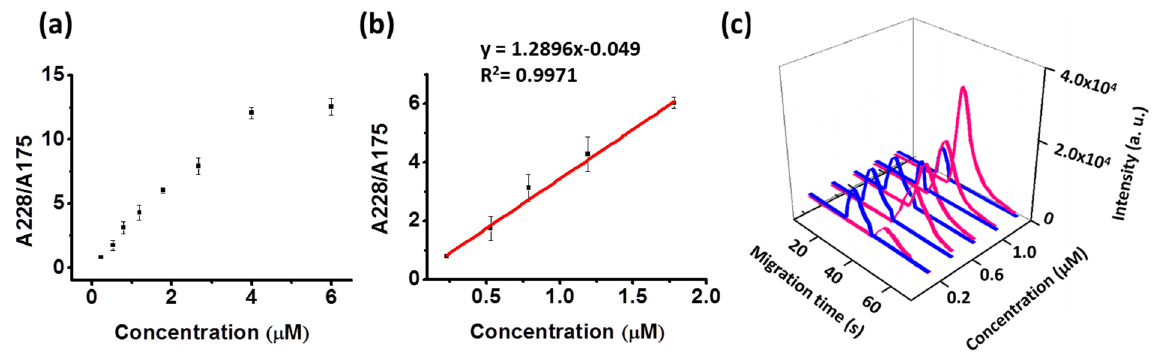
Figure 5. Quantitative analysis. ( a ) Plot obtained by plotting the ratio integrated intensity area of the ion peak from corresponding EICs at m / z 228 (ametryn) to the ion peak at m / z 175 (arginine) versus the concentration of ametryn. The samples contained ametryn with different concentrations (0.2–6 µ M) spiked with arginine (1.5 µ M). Three replicates were conducted for each concentration. The voltage applied on the inlet of the mass spectrometer was − 4.5 kV, while the length of the tapered capillary was ~2.5 cm. The running solvent was composed of acetonitrile/deionized water (2:8, v / v ). ( b ) Plot of the linear dynamic range (0.23–1.78 µ M) derived from Panel ( a ). ( c ) Representative EICs at m / z 175 (blue) and 228 (pink) used to plot Panel ( b ).